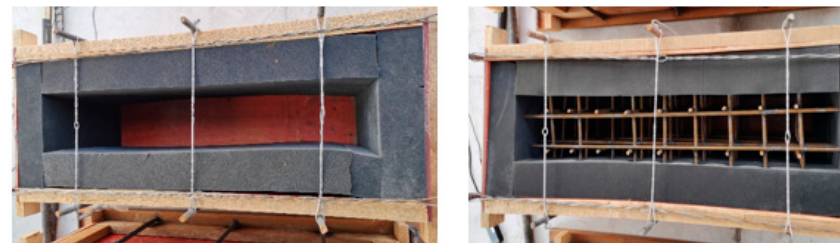
Figure 6. Test mold schematic diagram.